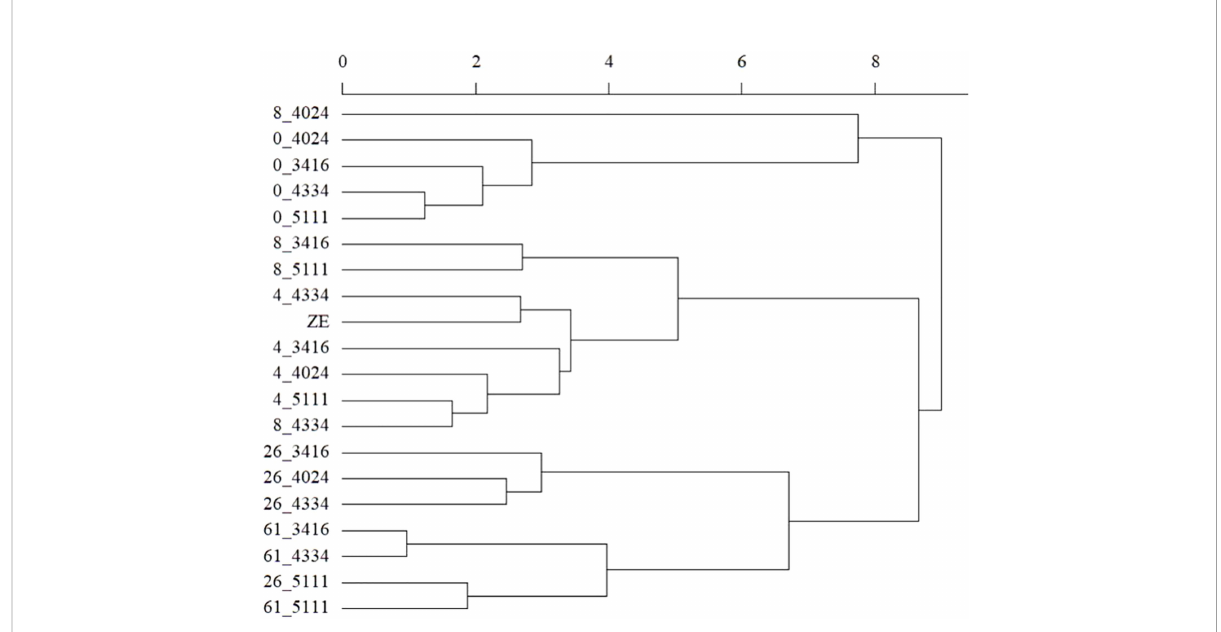
FIGURE 7 Hierarchical clustering analysis of zygotic embryos (ZE) and stored cotyledonary somatic embryos sampled at the end of maturation or after 4, 8, 26, or 61 weeks of cold storage (0, 4, 8, 26, and 61 respectively) of the cell lines 3416, 4024, 4334 or 5111. Clustering was based on the entire available quantitative dataset (fructose, galactose, glucose, maltose, sucrose, myo-inositol, chiro-inositol, stachyose, raf fi nose, and starch and total protein